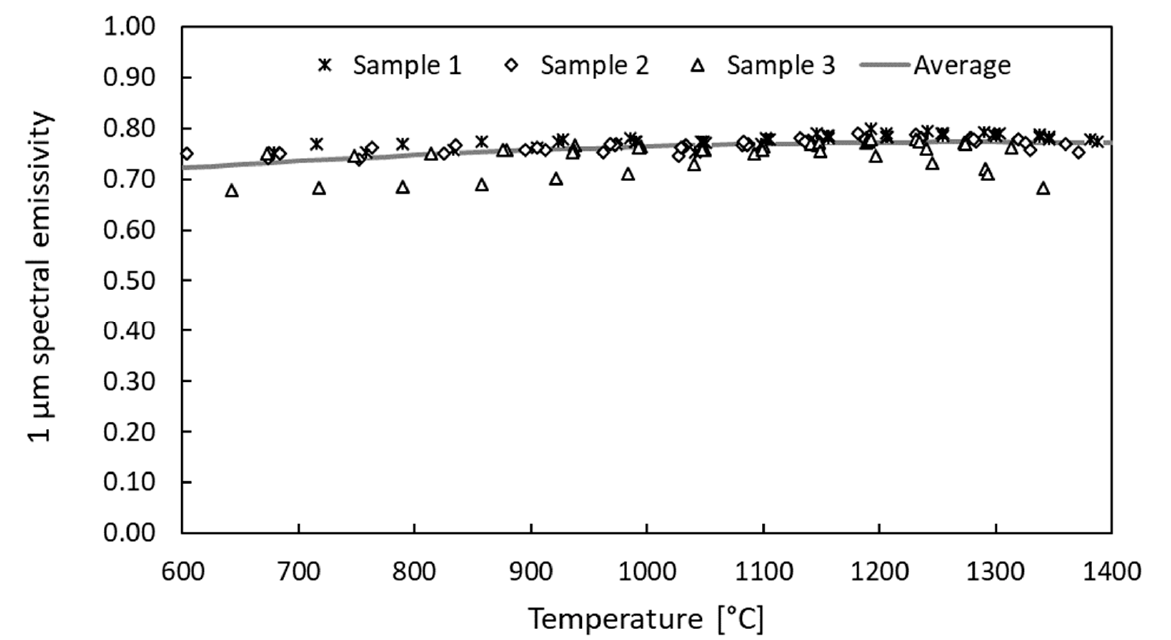
Figure 3. The 1 μ m spectral emissivity data collected for three different samples.